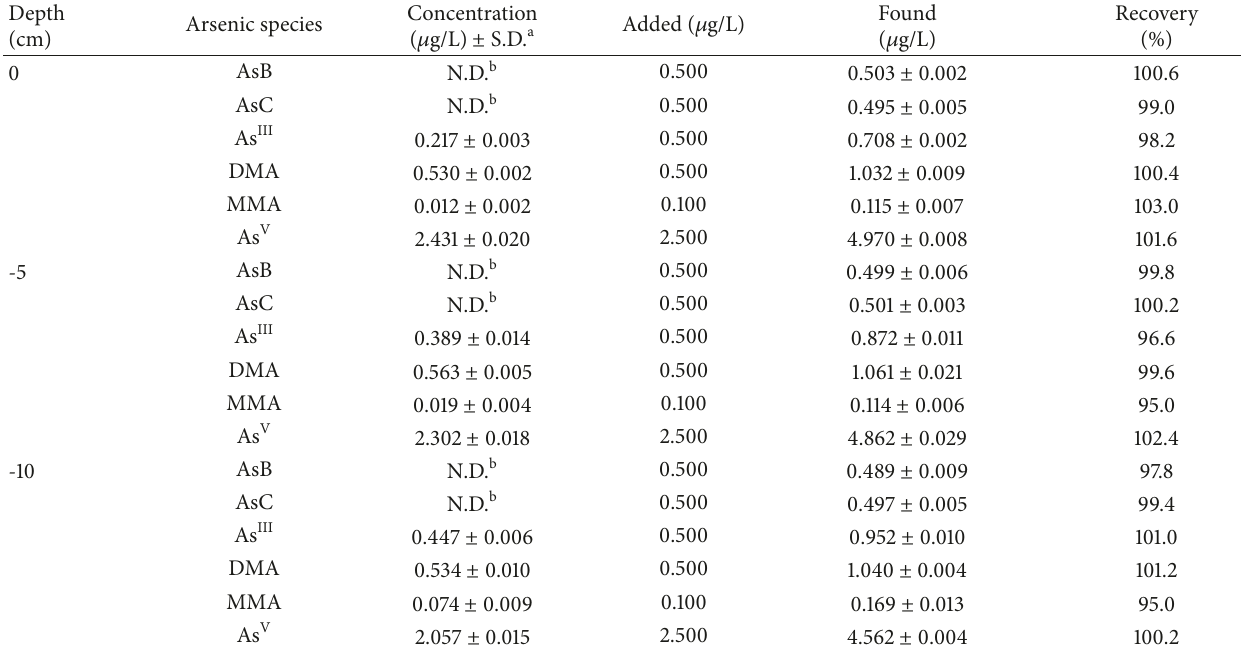
Table 4: Analytical results and recoveries of the sediment pore-water